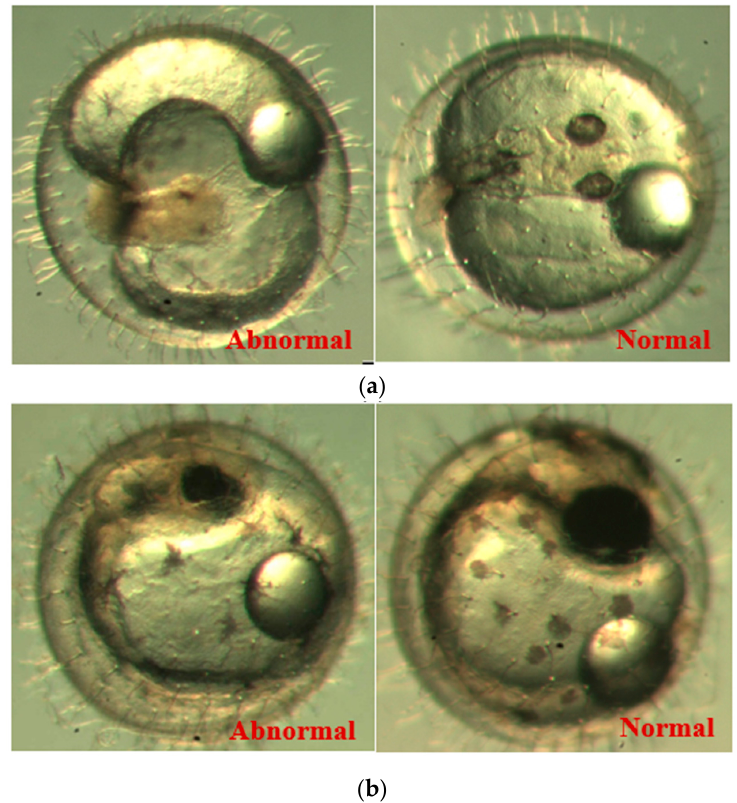
Figure 10. Abnormalities: ( a ) One of dish 5—abnormal body development; ( b ) One of dish 2—abnormal eye development.